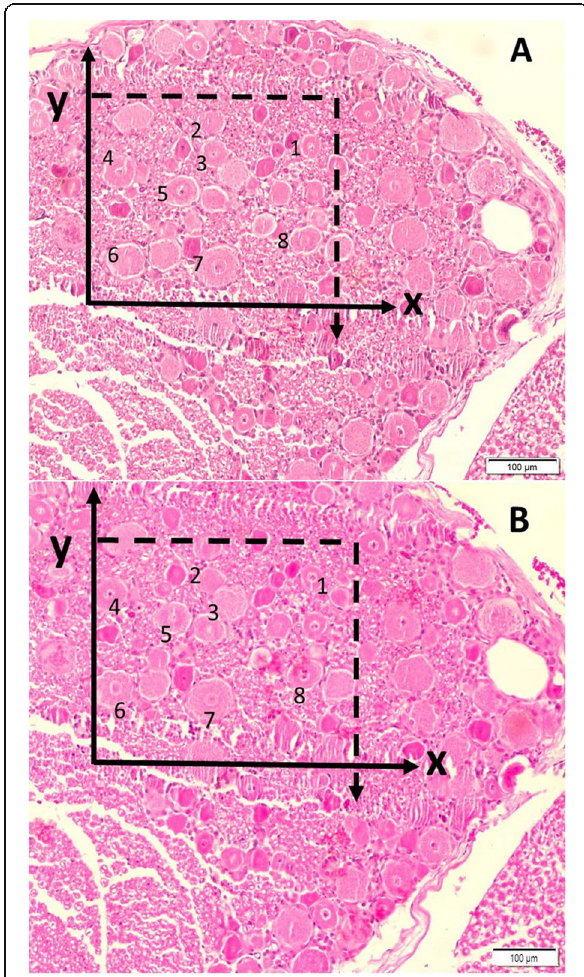
Fig. 3 Application of the physical dissector method, in which micrographs in the same fields of view ( a , b ) are taken from two parallel, adjacent thin sections separated by a distance of 5 mm. Upper and right lines of unbiased counting frames represent the inclusion lines; the lower and left lines, including the extensions, are exclusion lines. Any neuron nucleolus reaching the inclusion lines was excluded, and nucleolus profiles hitting the inclusion lines and located inside the frame were counted as dissector particles unless their profiles were extended up to the lookup section. The number of neurons from the two dissectors occurs in a volume given by the product of the counting frame area and the distance between the sections. The numerical density of the neurons is calculated as NvGN = Σ Q - GN/txA . In this application, the nucleoli marked with “ 1, 3, 6, 8 ” are dissector particles in a , which disappeared in b . The nucleoli marked “ 2, 4, 5, 7 ” are not dissector particles in a , which disappeared in b (H&E, 400, LM)